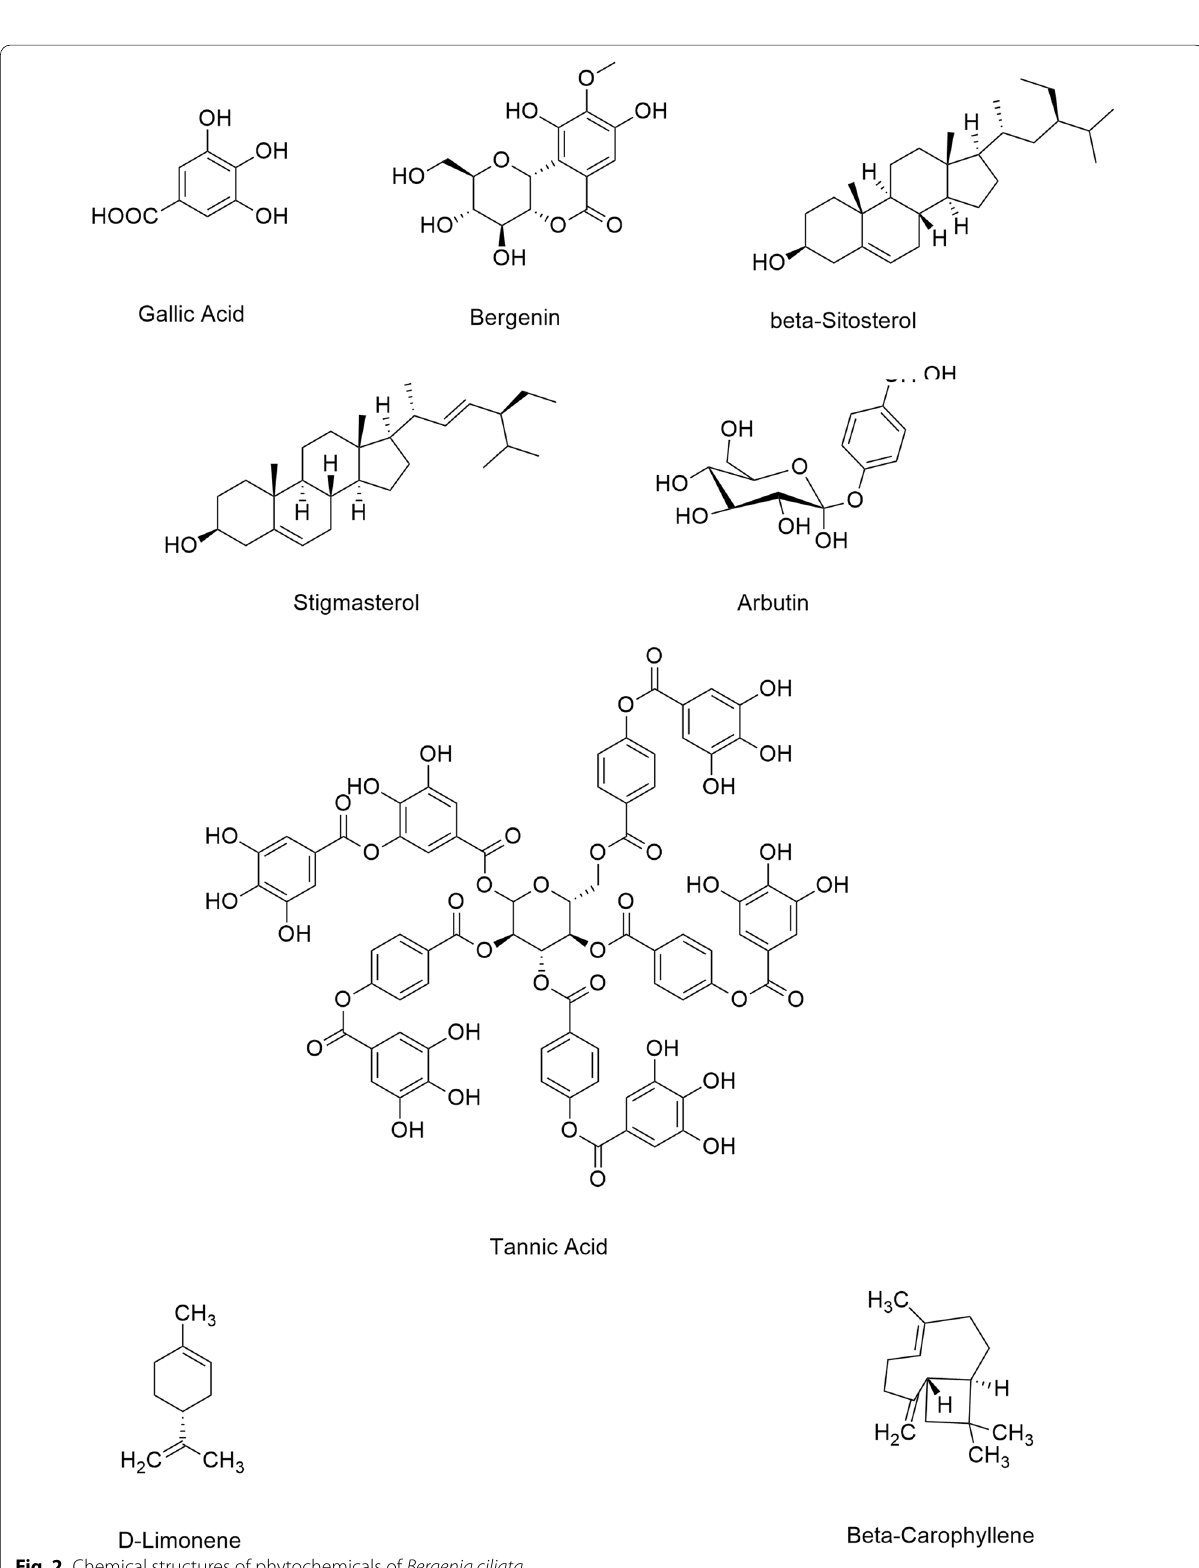
Fig. 2 Chemical structures of phytochemicals of Bergenia